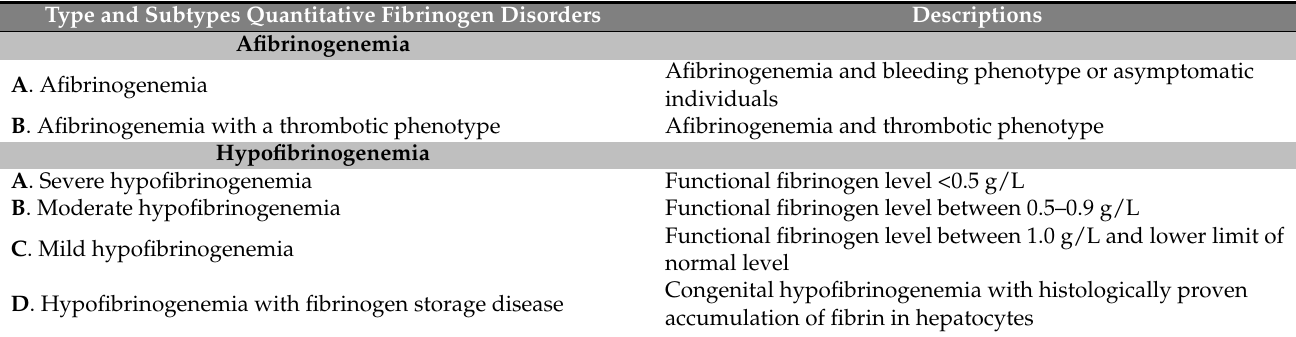
Table 1. Classification of congenital quantitative fibrinogen disorders